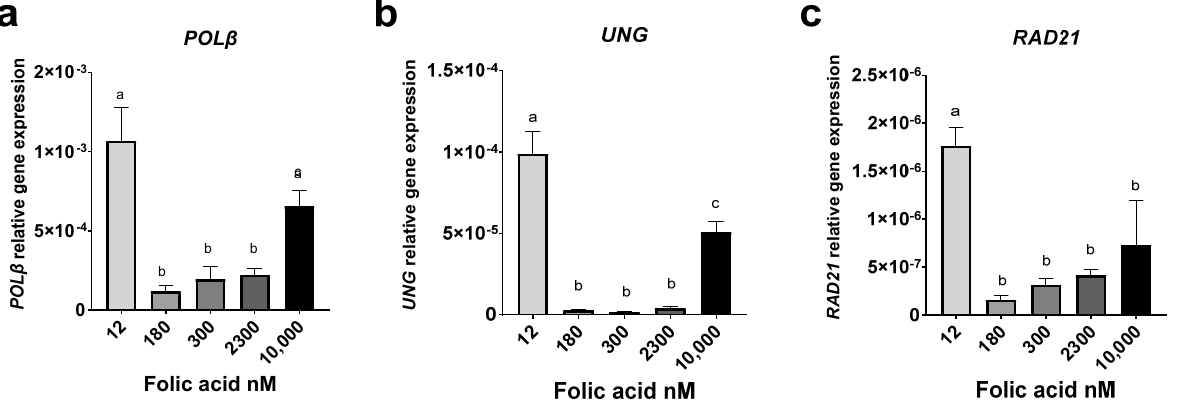
Figure 3. Impact of folate supplementation on the relative gene expression of DNA repair genes. ( a ) Effect of FA media concentration on the relative gene expression of POL β . ( b ) Effect of FA media concentration on the relative gene expression of UNG . ( c ) Effect of FA media concentration on the relative gene expression of RAD21 . Results are from technical triplicates ( n = 3). Bars, SEMs, and means with different letters (a,b,c) are significantly different (Tukey’s HSD, p < 0.05).